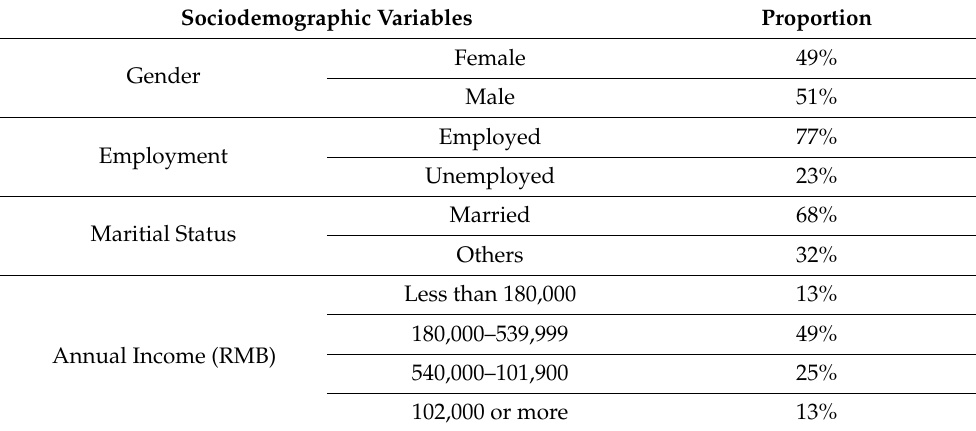
Table 4. Descriptive statistics of the Beijing participants’ sociodemographic